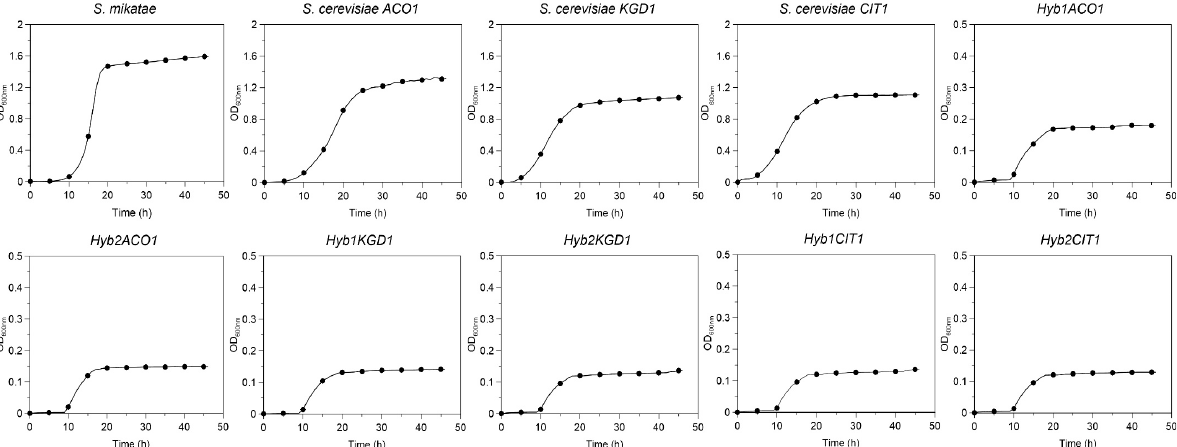
Figure 4. Aerobic growth of parental and hybrid strains in liquid 2% (w/w) YPD medium at 25 °C for 48 h. Each curve point represents an average value of 3 replications.